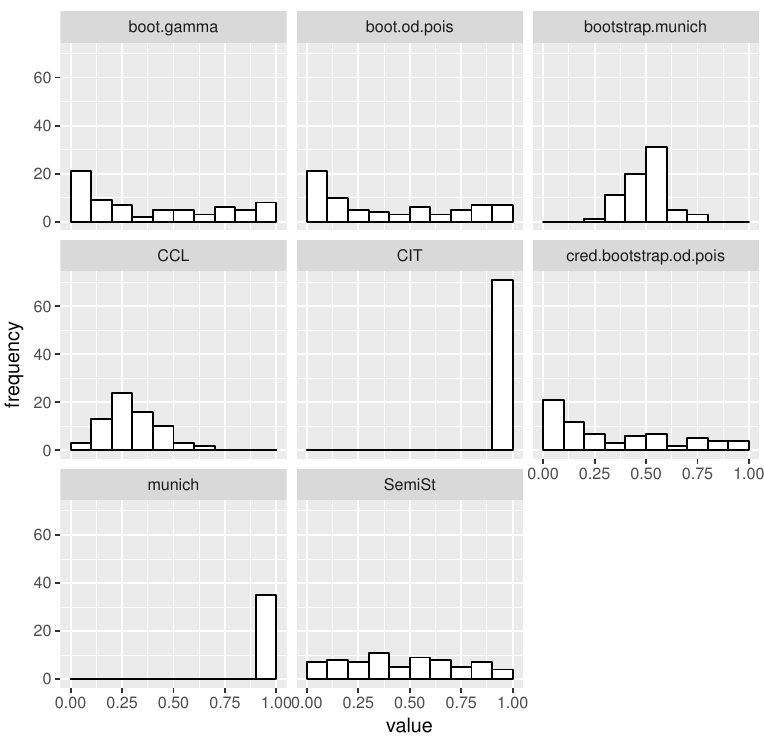
Figure 2. Histograms of PIT values from the commercial auto